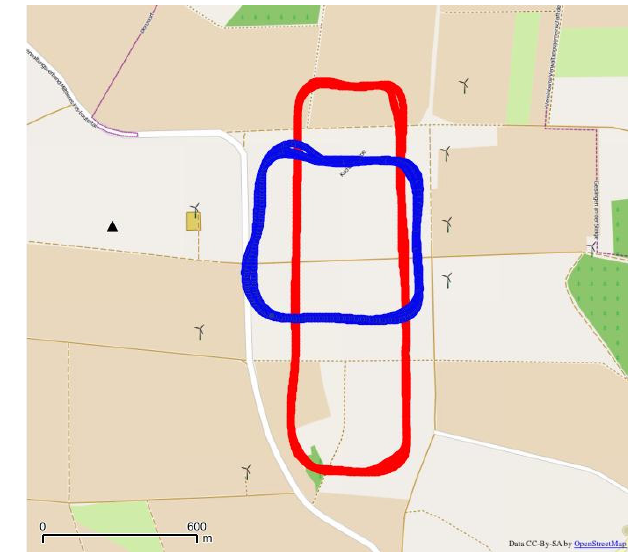
Figure 4. Extracts of recorded flight tracks at test site Schnittlingen. Vertical profiles up to 500m were measured with a square pattern (blue). Rectangular “racetrack” patterns at constant altitude serve to measure turbulence parameters (red). The position of the WECs can be seen from the OpenStreetMap layer, the measurement tower is depicted as a black